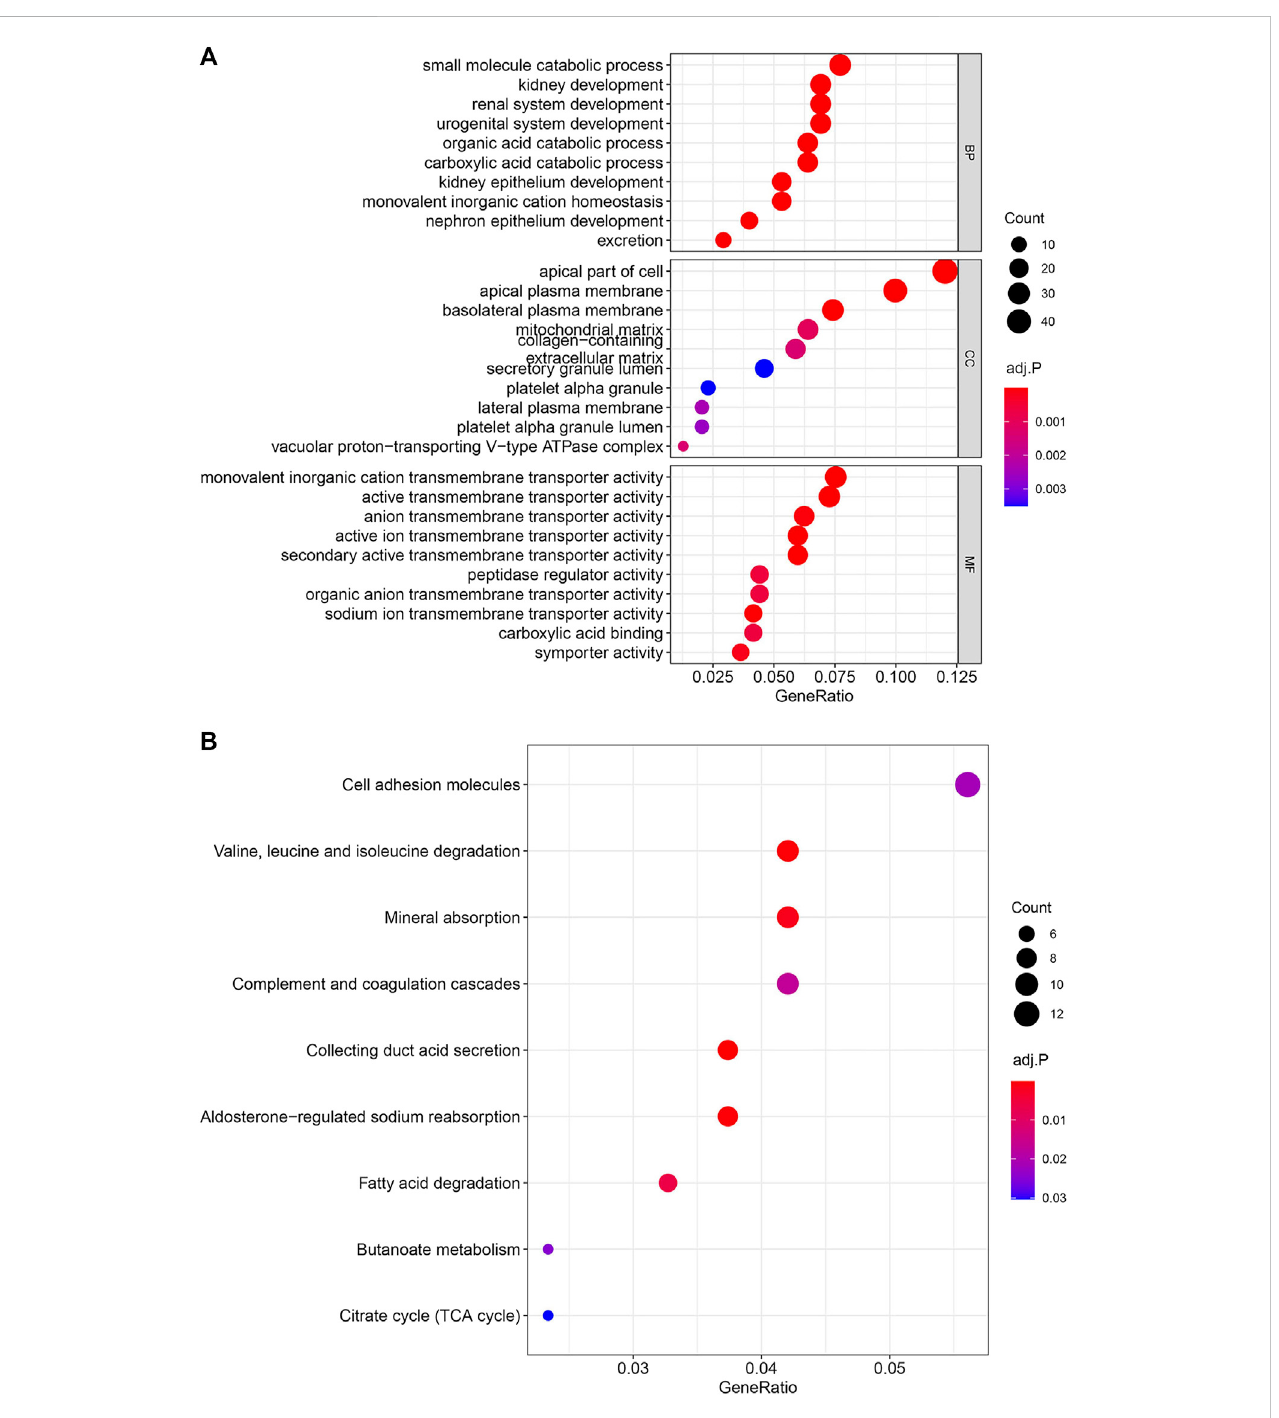
FIGURE 5 Enrichment Analysis of GO and KEGG. The color represents the adjusted p -values, and the size of the spots represents the gene number. (A) Gene Ontology (GO) analysis of the 397 overlapping genes. (B) KEGG analysis of the 397 overlapping